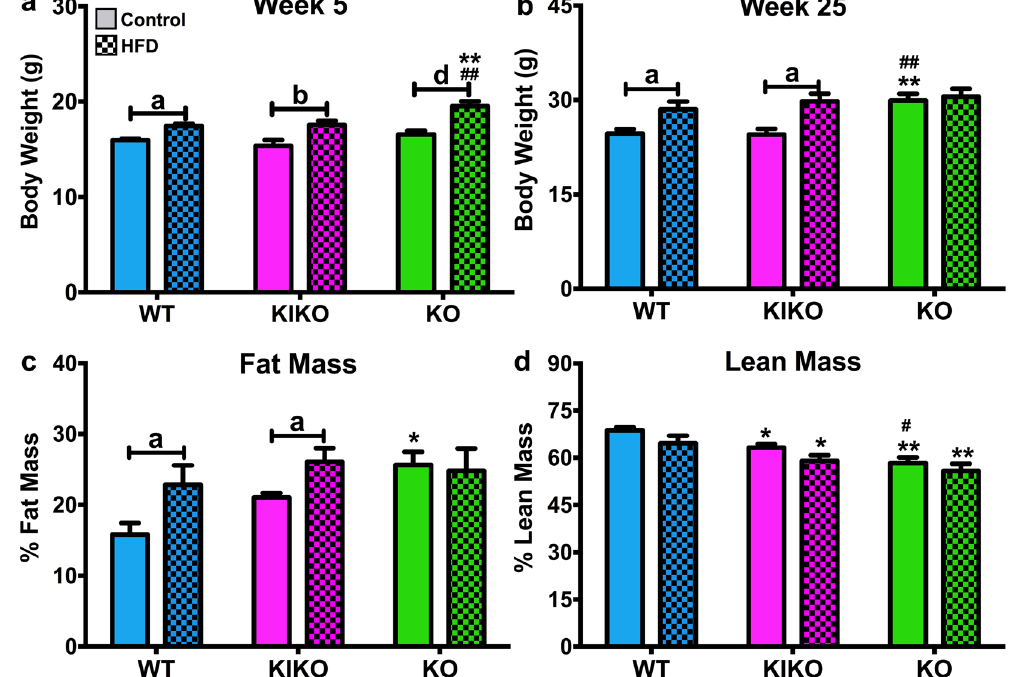
Figure 1. Body weight and body composition of adult females. ( a ) Body weights at week 5 in all genotypes from Control-fed and HFD-fed dams. ( b ) Body weights at week 25 in all genotypes after 20 weeks of a low-fat chow diet. ( c ) Percent body fat (fat mass/body mass) of female mice from all groups. ( d ) Percent lean mass (lean mass/ body mass) of female mice from all groups. Control = maternal control diet and HFD = maternal HFD. Data were analyzed by two-way ANOVA with post-hoc Newman-Keuls test. Sample sizes were 9 to 12 per genotype per treatment and data are expressed as mean ± SEM. Capped lines denote comparison between maternal diets within genotypes. Asterisks ( * ) denote comparison to WT within the same diet group. The pound sign ( # ) denotes comparison of KIKO and KO within the diet group. ( a/ * /# = P < 0.05; b/ ** /## = P < 0.01; c/ *** /### = P < 0.001; d/ **** /#### = P <